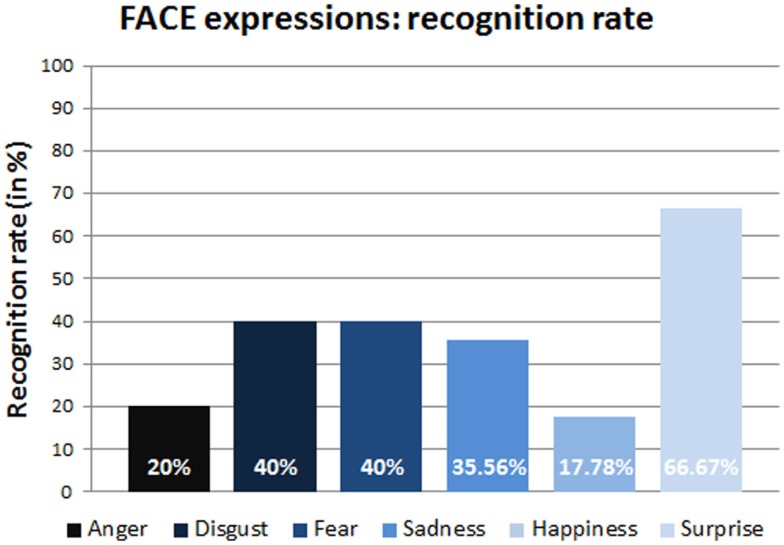
Recognition rates (in percentage) of the FACE expressions.